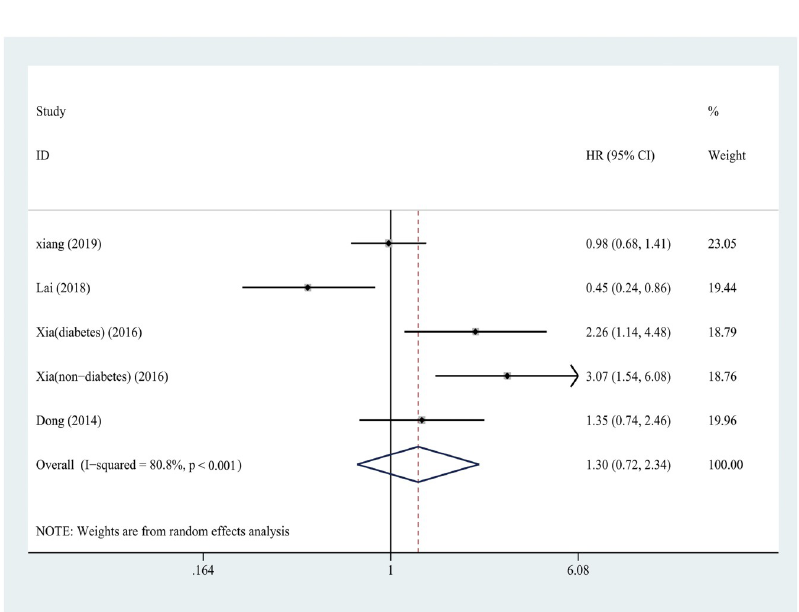
Fig 6. Forest plot about the relationship between SUA and cardiovascular mortality in PD patients. SUA, serum uric acid; PD, peritoneal